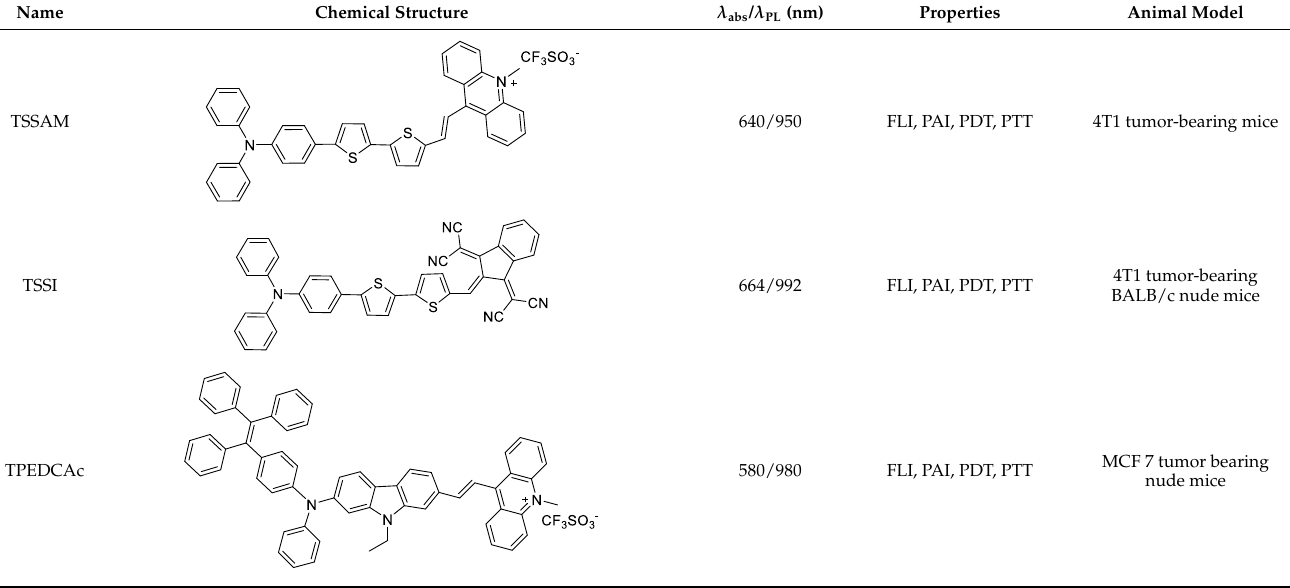
Table 1. Summary of Photodynamic NIR-II AIEgens for Different Biomedical Applications.